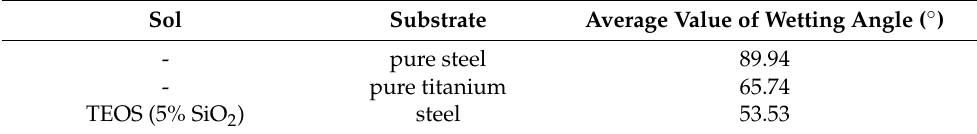
Table 5. Wetting angle values of pure metallic substrates and selected thin